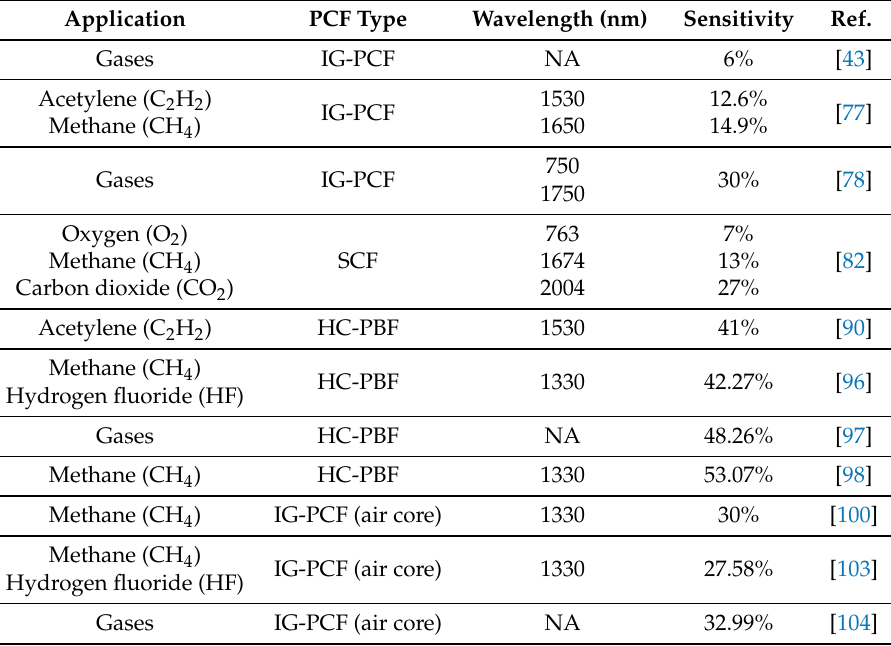
Table 1. Properties of most relevant gas-infiltrated PCF